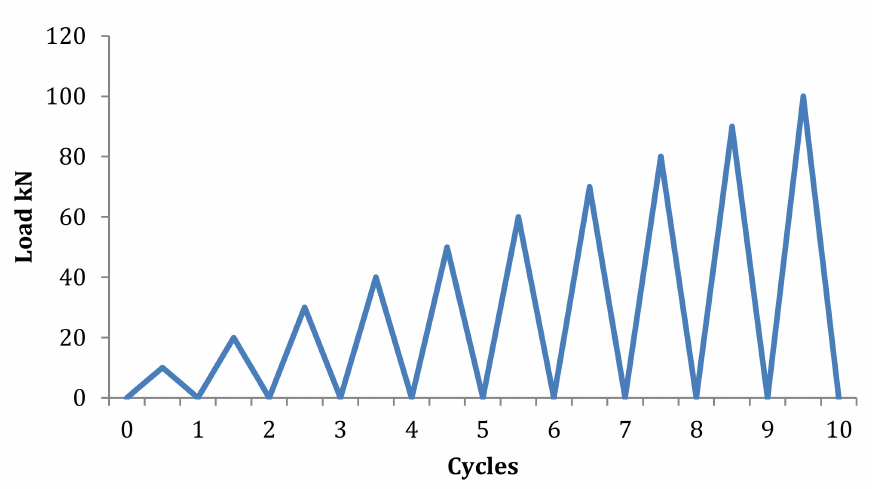
Figure 6. Repeated loading